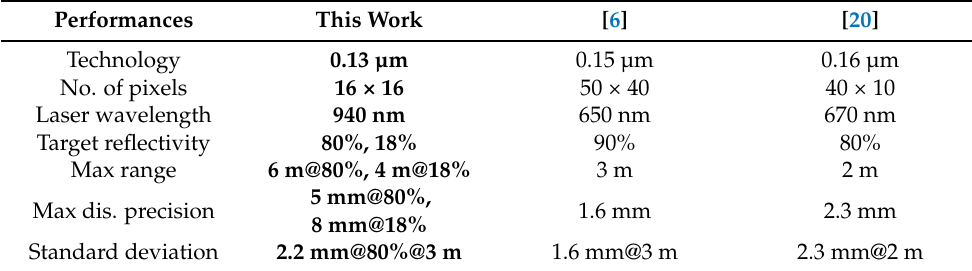
Table 1. System performance summary and comparison